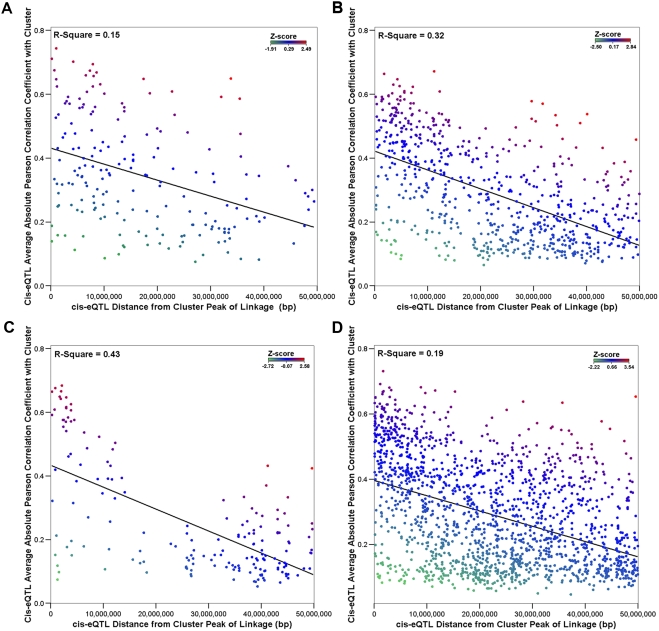
Scatter plots showing correlation of genes underlying cluster trans-eQTLs and cis-eQTLs located in the window region, plotted against their distance from the peak of linkage.Each point on the scatter plot represents a cis-eQTL within the defined window region of a trans-eQTL cluster. The average Pearson coefficient of correlation of the underlying transcript expression levels of the cis-eQTL with those of the cluster trans-eQTLs is shown to be strongly negatively correlated with distance in a) fat, b) kidney, c) adrenal, d) LV, R2 for this relationship ranges from 0.15 to 0.43. The Z-score, calculated from the vertical distance of each cis-eQTL from the regression line, is indicated by the colour of each point, indicated by the colour legend in the top right of each plot.